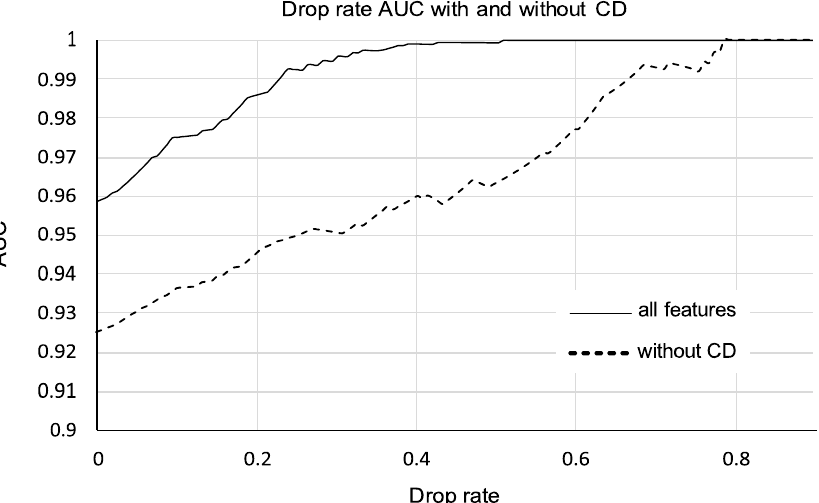
Figure 3. Drop rate curve with and without CD features. Using CD features reduces proportion of indeterminate cases. Pruning such cases at a 20% drop rate increased performance from AUC = 0.958 ± 0.022 to AUC = 0.986 ± 0.007 with 100% sensitivity. (CD = Color Doppler; AUC = Area under the